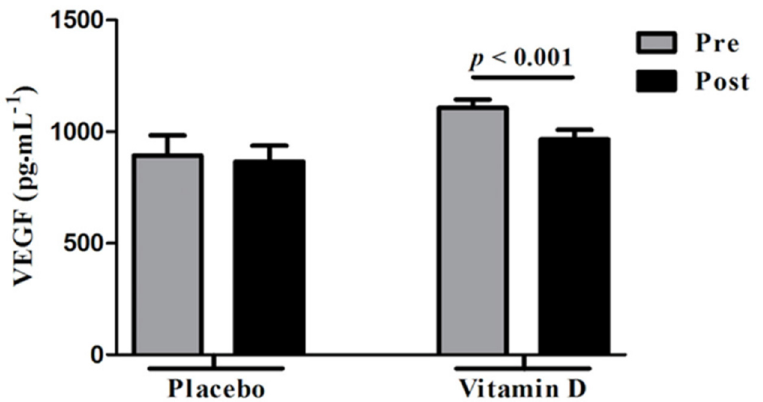
Figure 6. Effect of vitamin D supplementation on vascular endothelial factor (VEGF) levels in comparison with placebo. Vit D supplementation was associated with significantly reduced serum VEGF levels in vitamin D deficient women with polycystic ovarian syndrome (PCOS). No significant changes were observed with placebo. Pre: Before vitamin D or placebo, Post: After vitamin D or placebo administration. Reprinted/Adopted from reference [110], with permission.